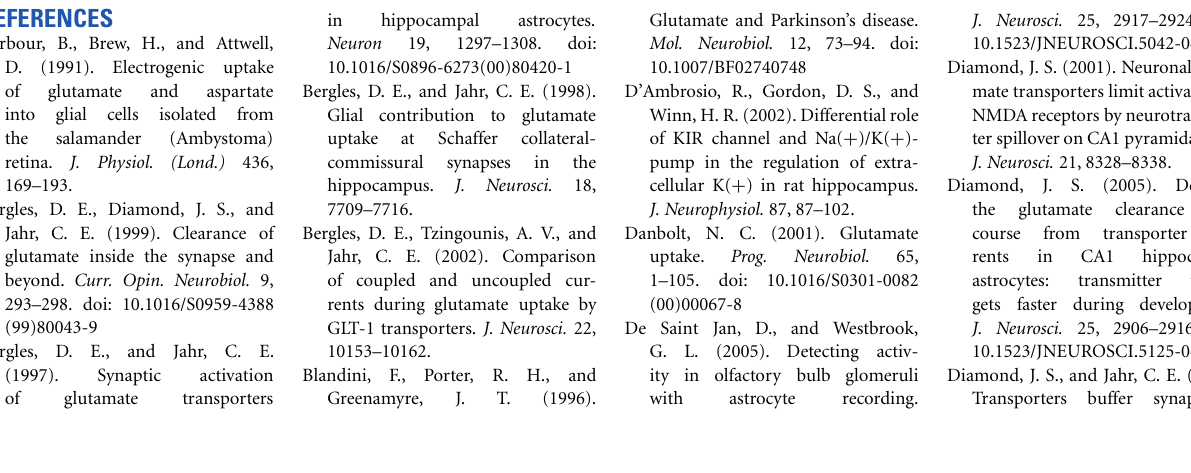
EAAT1 in control conditions (Ctrl), in the presence of 2 µ M TFB-TBOA, or in the presence of 1 µ M BaCl 2 (Ba 2 + ). (C) Summary graph of aspartate uptake by HeLa cells expressing EAAT2 in control conditions (Ctrl), in the presence of 2 µ M TFB-TBOA, or in the presence of 1 µ M BaCl 2 (Ba 2 + ). Error bars—SEM. ∗∗ P < 0 . 01; N.S.—non significant; unpaired t